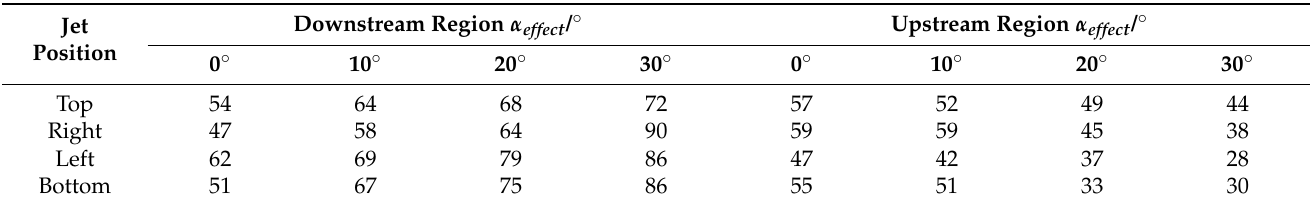
Figure 6. The distribution of local convective heat transfer coefficient ( h ) along the circumferential direction angle ( α ). ( a ) Top jet; ( b ) right jet; ( c ) left jet; ( d ) bottom jet. Table 2. The α ef fect of top jet, right jet, left jet and bottom jet along the circumferential